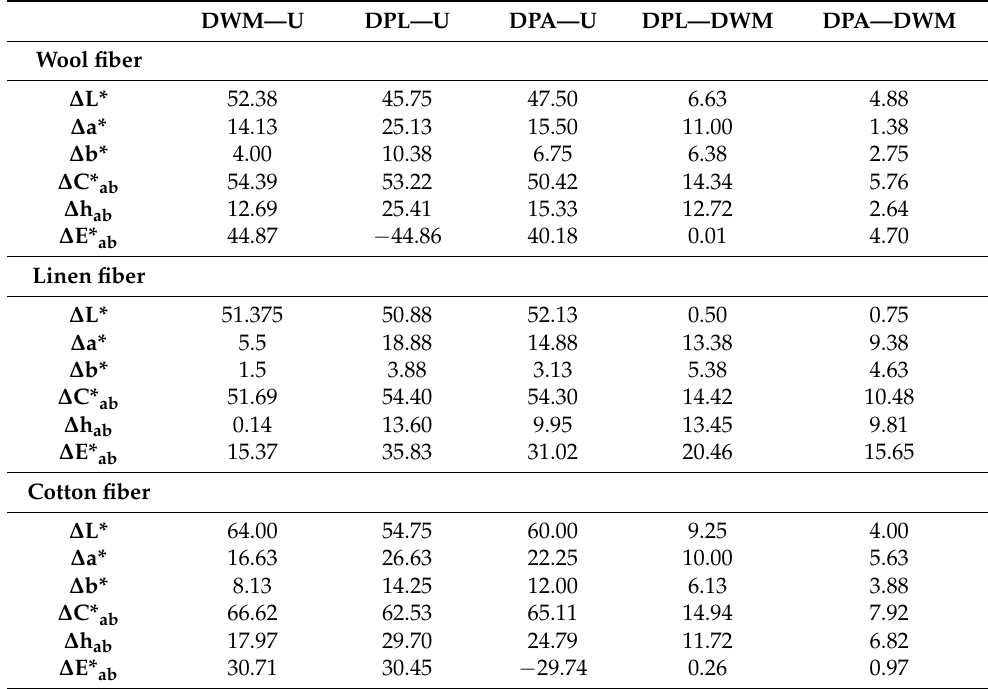
Table 9. Partial color differences ( ∆ L*, ∆ a* and ∆ b*), ‘chroma’ differences ( ∆ C* ab ), ‘hue angle’ differences ( ∆ h ab ) and total color difference ( ∆ E* ab ) between the dyed fabrics.